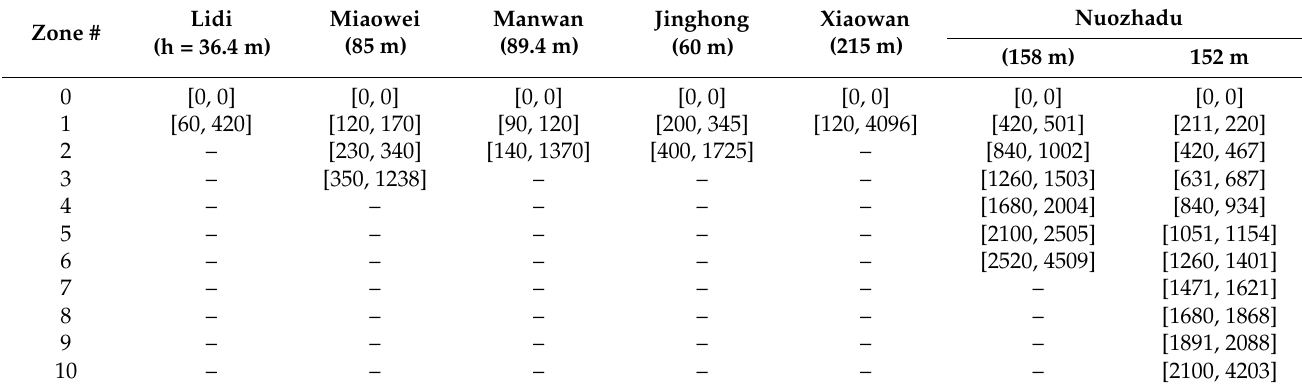
Table 5. Results of plant-based operating zones at a water head.